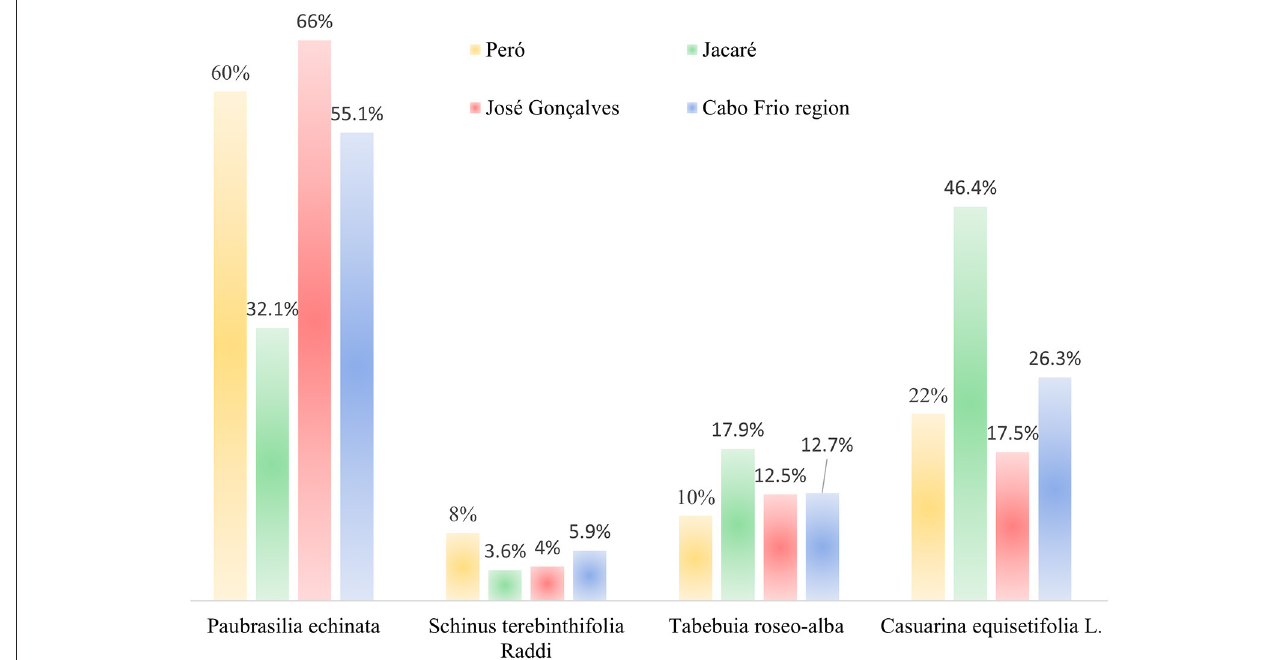
FIGURE 4 | Results of the visual stimuli technique among the interviewees in the municipalities of Cabo Frio (Peró and Jacaré) and Armação dos Búzios (José Gonçalves) in the state of Rio de Janeiro, Brazil.